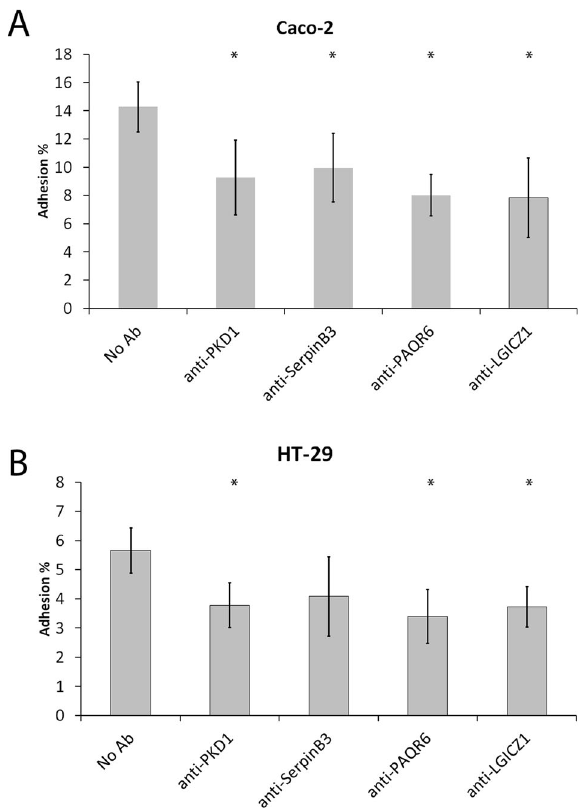
Fig. 5 Results of the adhesion blocking assay. Adhesion of B. bi fi dum to Caco-2 ( A ) and HT-29 ( B ) cell lines and the effect of antibody-blocking of the four speci fi c receptors on adhesion level. The results of 5 technical replicates (parallel wells) from the representative experiments are expressed as means ± standard deviations. Signi fi cant reductions ( P < 0.05) in the adhesion in the inhibition assays as compared to the basic adhesion assay are indicated with asterisks. A pairwise Student ’ s t-test was used to determine the signi fi cant difference ( P <